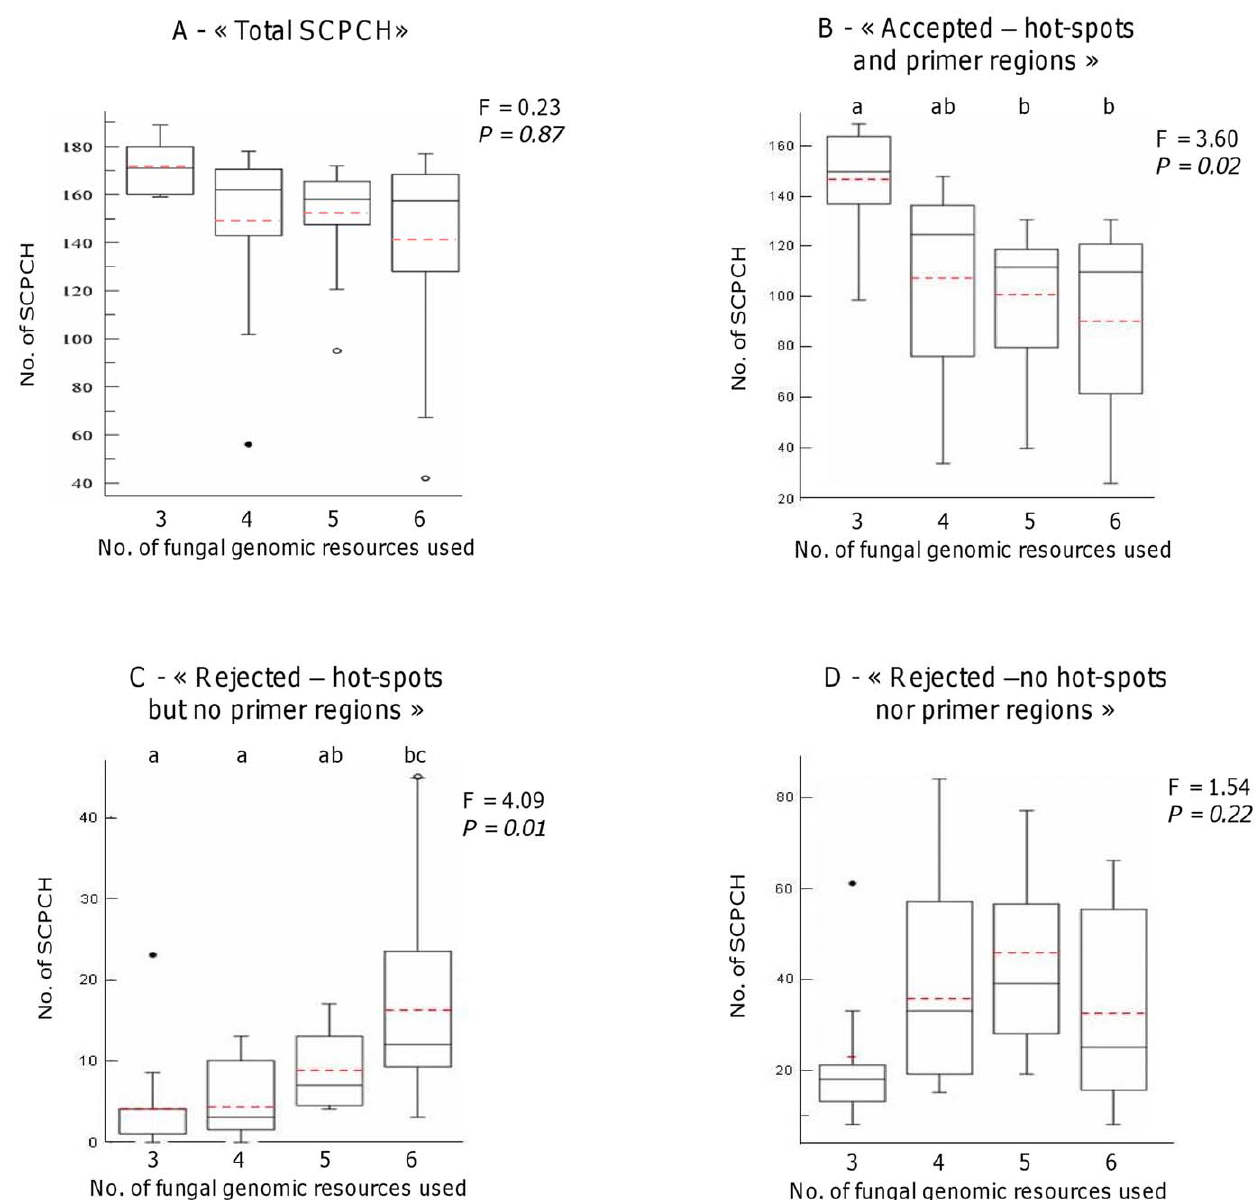
Figure 2. Number of candidate SCPCH obtained in 40 different PHYLORPH runs. The distributions are represented with boxplot depending on the number of fungal genomic resources used (3 to 6 i.e. one species dataset from FUNYBASE and 2–5 full genome sequence; see Table S2) in the different runs. Boxplot representations include the median (central bar), the mean (dotted red line), the position of the upper and lower quartiles (called Q1 and Q3; central box), extremes of the data (‘‘whiskers’’) and very extreme points that can be considered as outliers (dots; points that exceed Q1 + 1.5IQR and Q1-1.5IQR for the upper and lower parts of the distribution, respectively, where IQR=Q3-Q1). Letters above boxplots indicate significant differences between groups as determined by a Tukey’s HSD test after significant one-way ANOVA (F and P-values on the right). ‘‘Accepted’’ are candidates SCPCH which contain both «mutation hot-spot» and «priming site» regions; « Rejected – no primers » are those which contain only « mutation hot-spot » region(s); « Rejected » are those with no «mutation hot-spot» nor « priming site » regions; ‘‘Total’’ includes all the SCPCH (‘‘Accepted’’ + « Rejected – no primers » + « Rejected ») retrieved in the searches. doi:10.1371/journal.pone.0018803.g002 Erysiphe alphitoides and E. quercicola (oak powdery mildews), North amplify and sequence the expected DNA fragment. Based on observed sequence conservation/variation between Blumeria American and Eurasian lineages of Heterobasidion annosum , individ- graminis, Sclerotinia sclerotiorum and Botrytis cinerea , PHYLORPH uals of Armillaria ostoyae and cryptic species of the Hymenoscyphus albidus / H. pseudoalbidus (anamorph Chalara fraxinea ) complex. proposed 133 ‘‘Accepted’’ SCPCH for oak powdery mildews. We performed experimental validation on a panel of 12 SCPCH. After PCR and sequencing success. For each group of non- model species tested, the primer pairs for 10 to 14 of the SCPCH ‘‘classical’’ PCR with annealing at 55 u C, two candidate SCPCH proposed by PHYLORPH were tested for their capacity to yielded amplification products of the expected size in E. alphitoides /